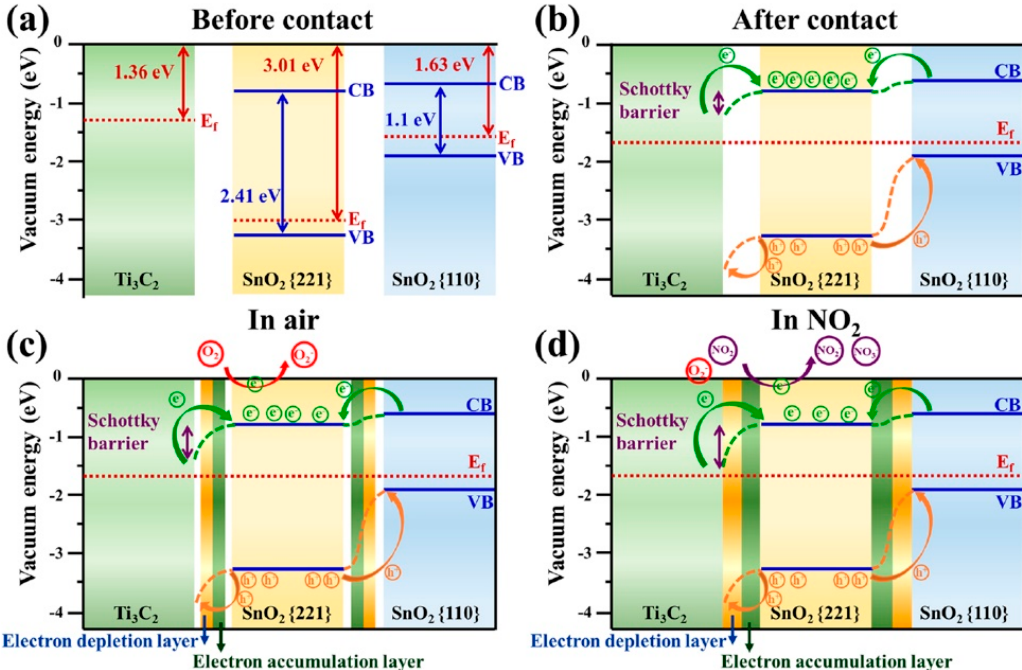
Figure 17. ( a ) Band structures of Ti 3 C 2 , SnO 2 {221} and {110} facets before contact, and variations of Schottky barrier of SnO 2 /Ti 3 C 2 composite under different conditions: ( b ) after contact, ( c ) in air, and ( d ) in NO 2 . Reprinted with permission from [120]. Copyright 2022: Elsevier B.V.